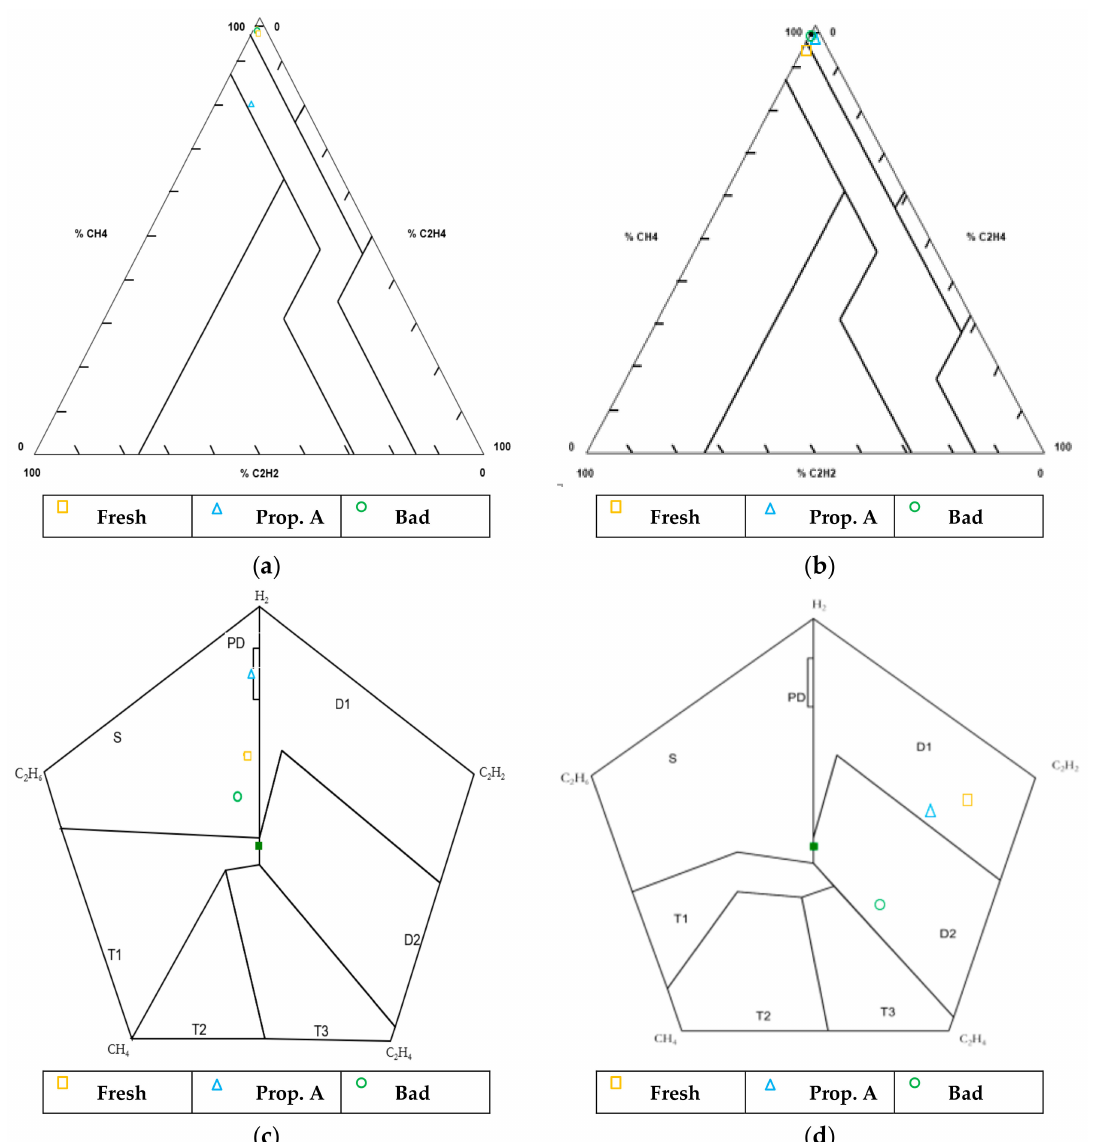
Figure 7. Representation of fault gasses in Duval’s triangle and Duval’s pentagon for mineral oil and synthetic ester at di ff erent aging factors: ( a ) Duval’s triangle for mineral oil; ( b ) Duval’s triangle for synthetic esters; ( c ) Duval’s pentagon for mineral oil; ( d ) Duval’s pentagon for synthetic